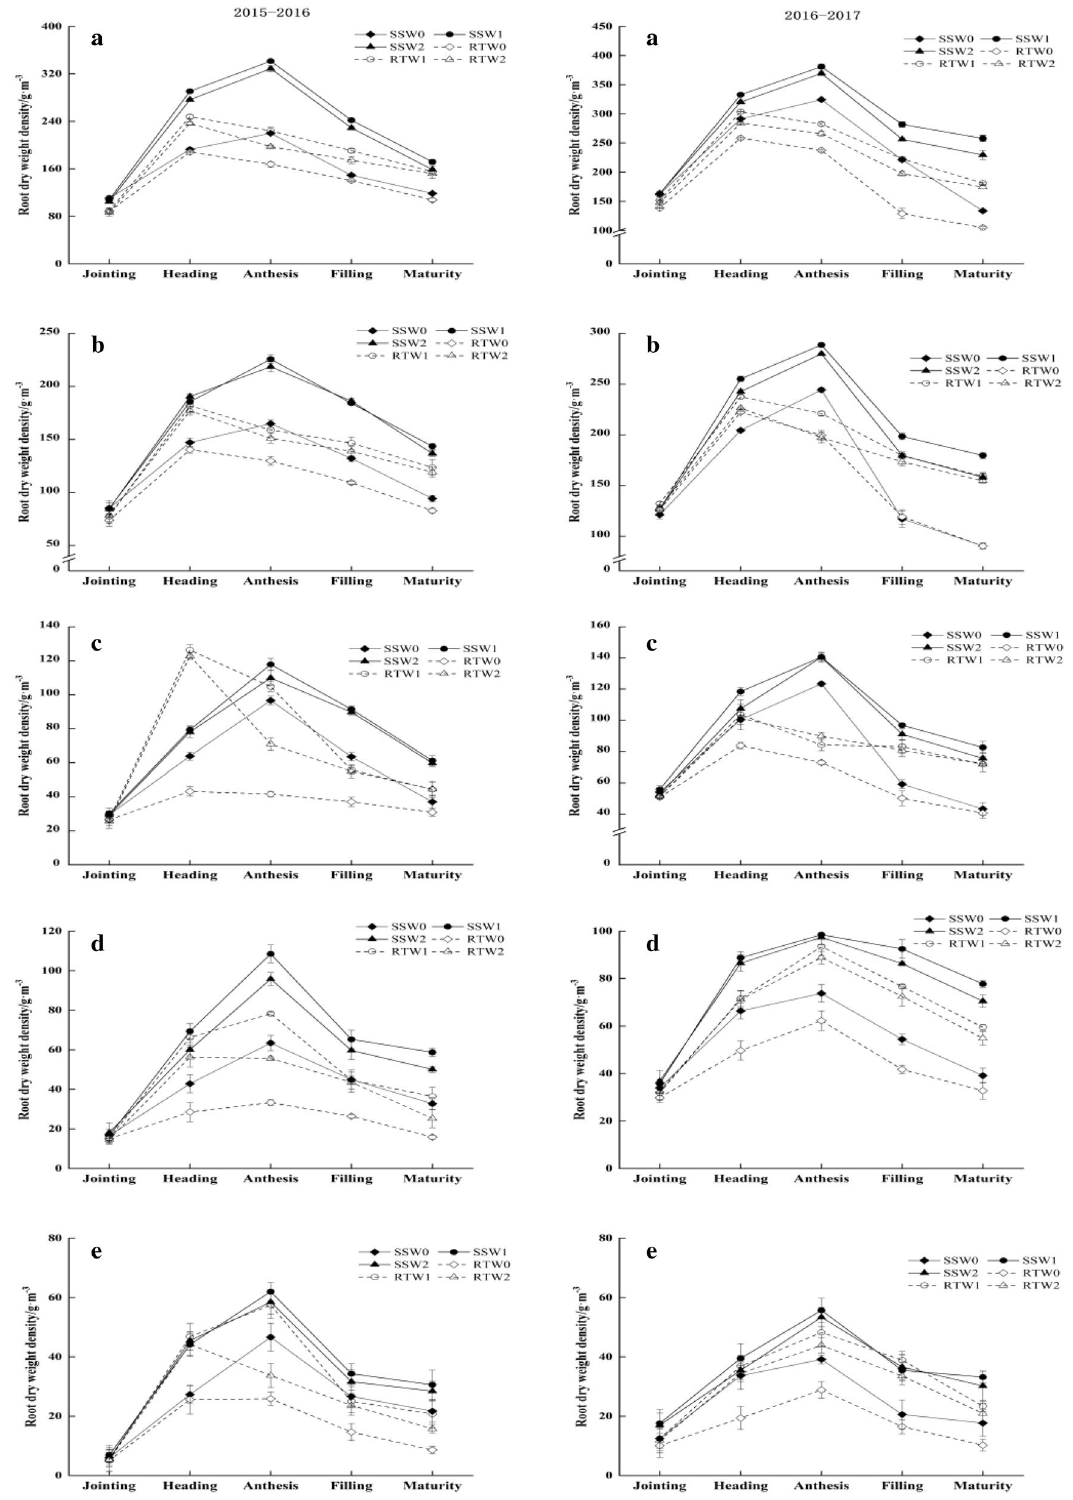
Figure 1. Effects of tillage practice and irrigation regime on the dry root weight density of winter wheat in different soil layers. Note : a, b, c, d and e represent the soil layer of 0–20 cm, 20–40 cm, 40–60 cm, 60–80 cm and 80–100 cm,